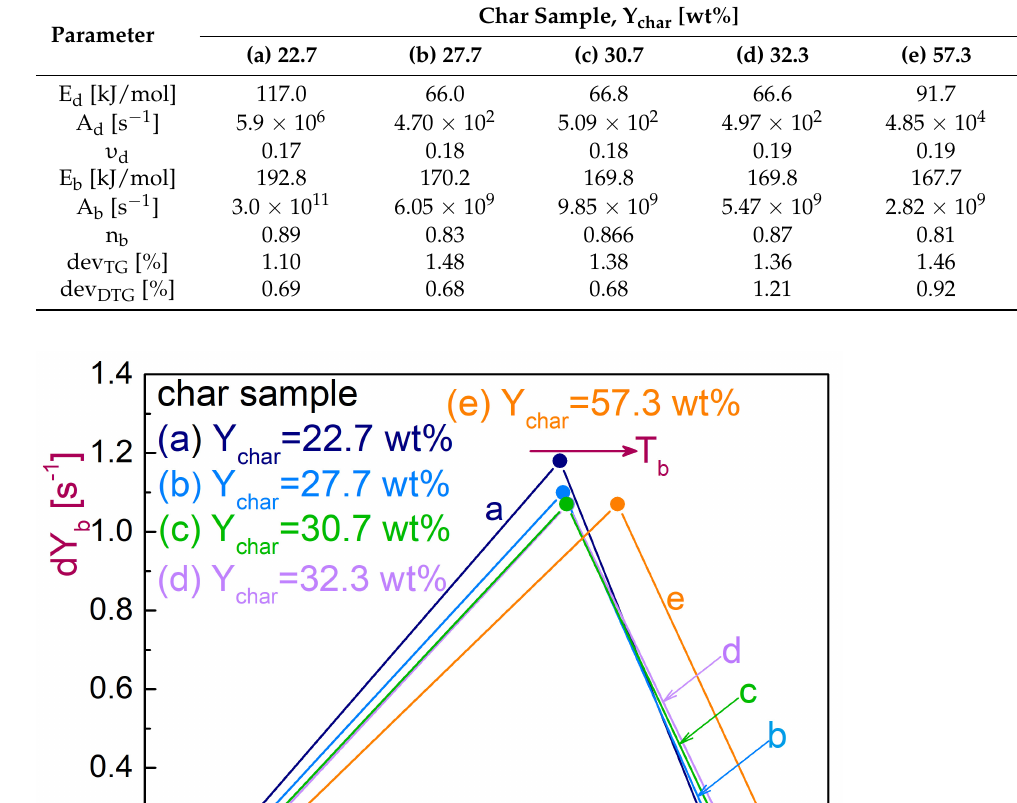
Table 2. Estimated kinetic parameters (activation energy, E, pre-exponential factor, A, reaction order, n, and stoichiometric coefficient, υ , for the devolatilization (d) and oxidation (b) reactions, and deviations between predicted and measured integral and differential curves, dev TG and dev DTG , respectively, for the pyrolysis chars (torrefaction conditions listed in Table 1).